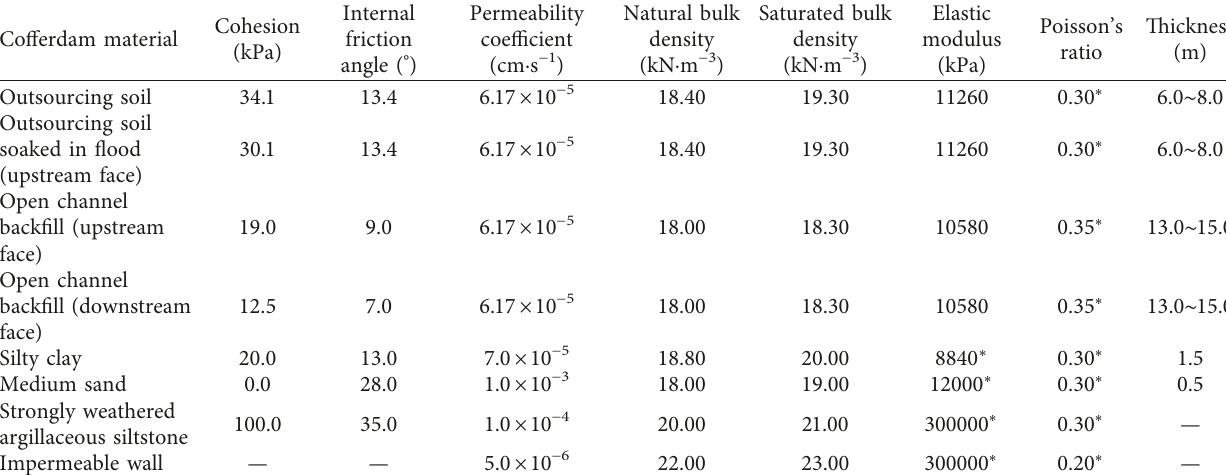
Figure 8: Cofferdam structure and filling distribution. Table 1: Properties of soils/rocks of the cofferdam and